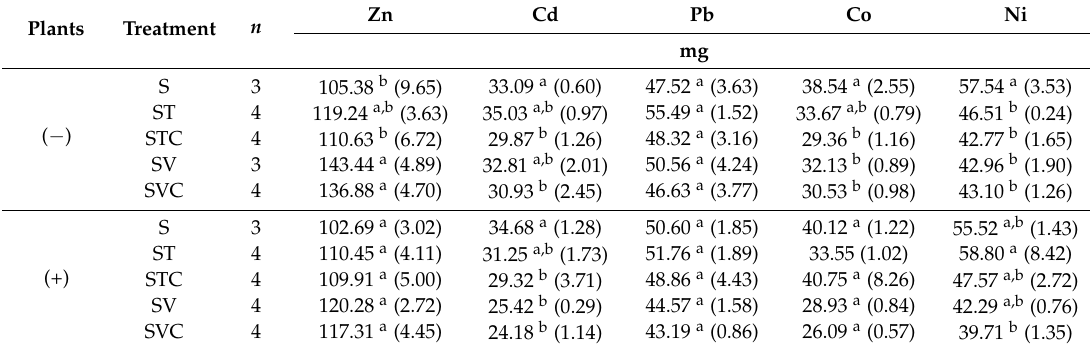
Figure 3. Mean ± 1 S.E. switchgrass shoot metal mass ( µ g) in soil (S) amended with thermophilic (T) and vermicompost (V) with and without coir (C). Varying letters indicate significant differences in shoot metal mass across treatments for each metal species. Table 6. Total heavy metal mass in control soil (S), and control soil amended with thermophilic (T) and vermicompost (V) with and without coir (C) from unvegetated ( − ) and vegetated (+) pots at the end of the 54-day incubation period. Numbers inside parenthesis indicate ± 1 S.E. ( n = number of replicates/pots).